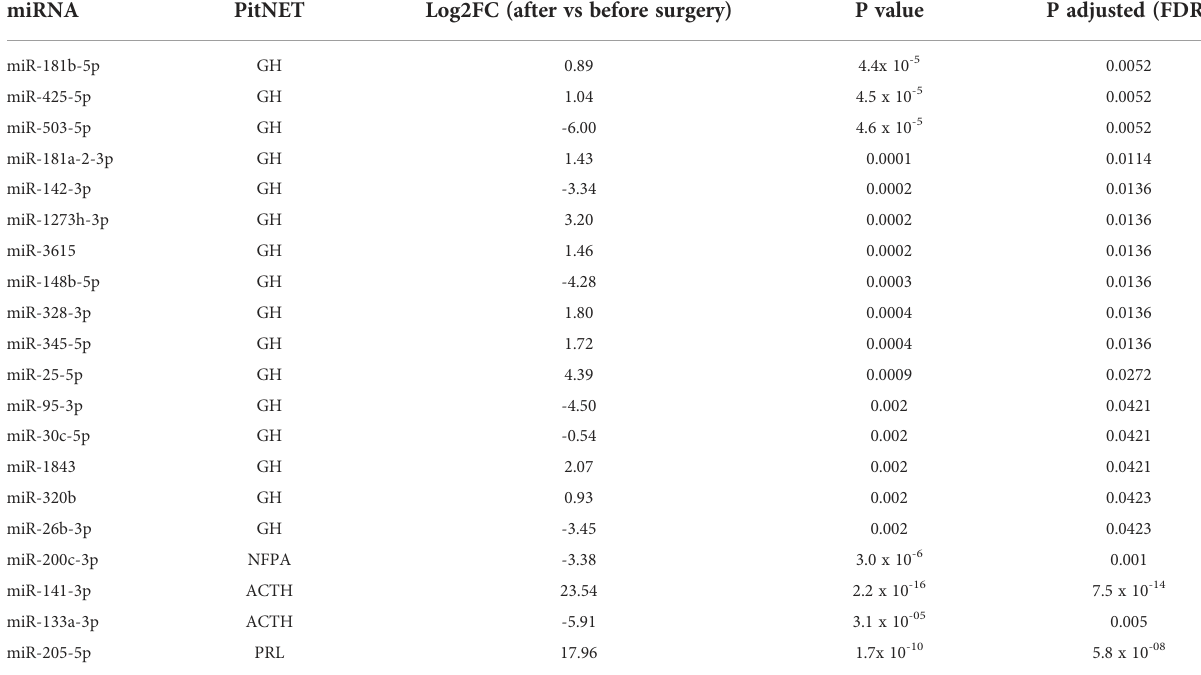
TABLE 1 Results of differential expression analysis of postoperative vs. preoperative plasma from PitNET patients. miRNA PitNET Log2FC (after vs before